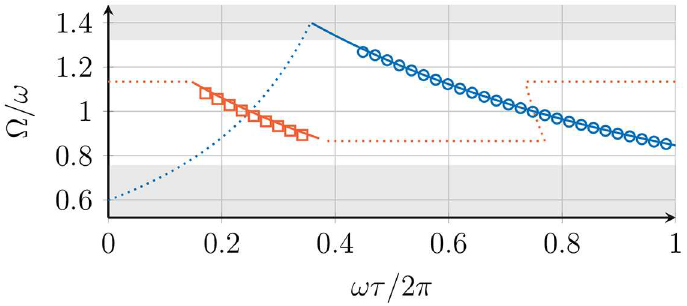
Fig 12. Experimental measurements of the collective frequencies Ω for three coupled DPLLs. Collective frequency Ω of the in-phase (blue circles) and m -twist synchronizedstates with m = 1, 2 (red squares)for a ring of 3 mutually coupledDPLLs as a function of the transmissiondelay τ . Symbols show experimental data points. Color code as in Fig